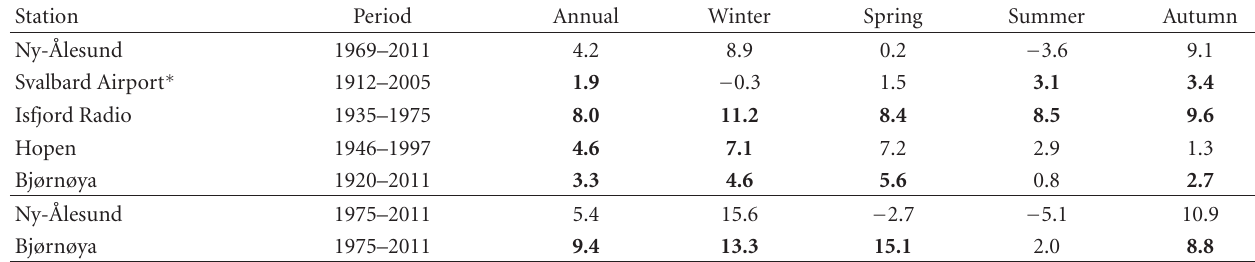
Table 4: Linear precipitation trends (% per decade) in the Svalbard region. Trends significant at the 5% level are bold. The statistical significance of the trends was tested by the Mann-Kendall nonparametric test [21]. The trend analysis for Svalbard Airport and Hopen do not include the latest years because of relocation of gauges. Absolute trends in millimetres may be deduced by combining with the 1961–1990 averages in Table